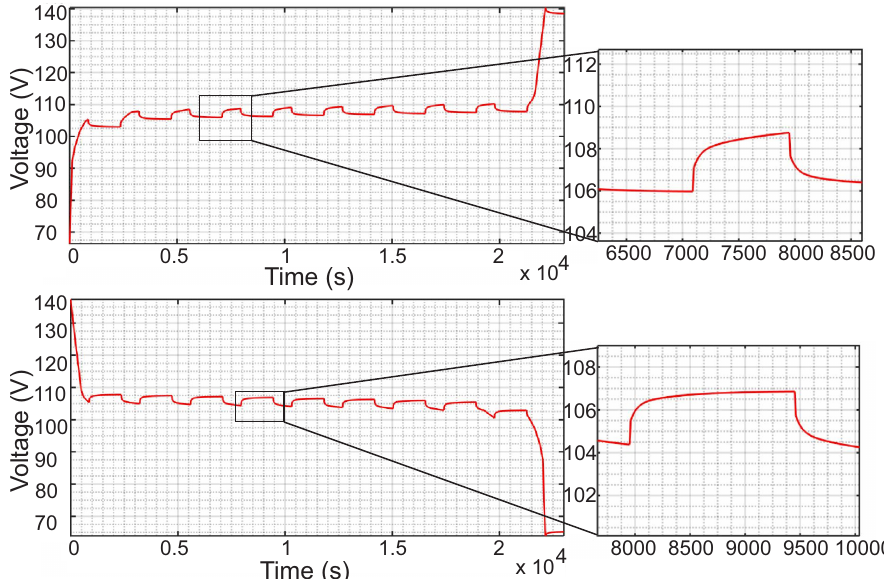
Figure 9. Battery voltage variation during charging and